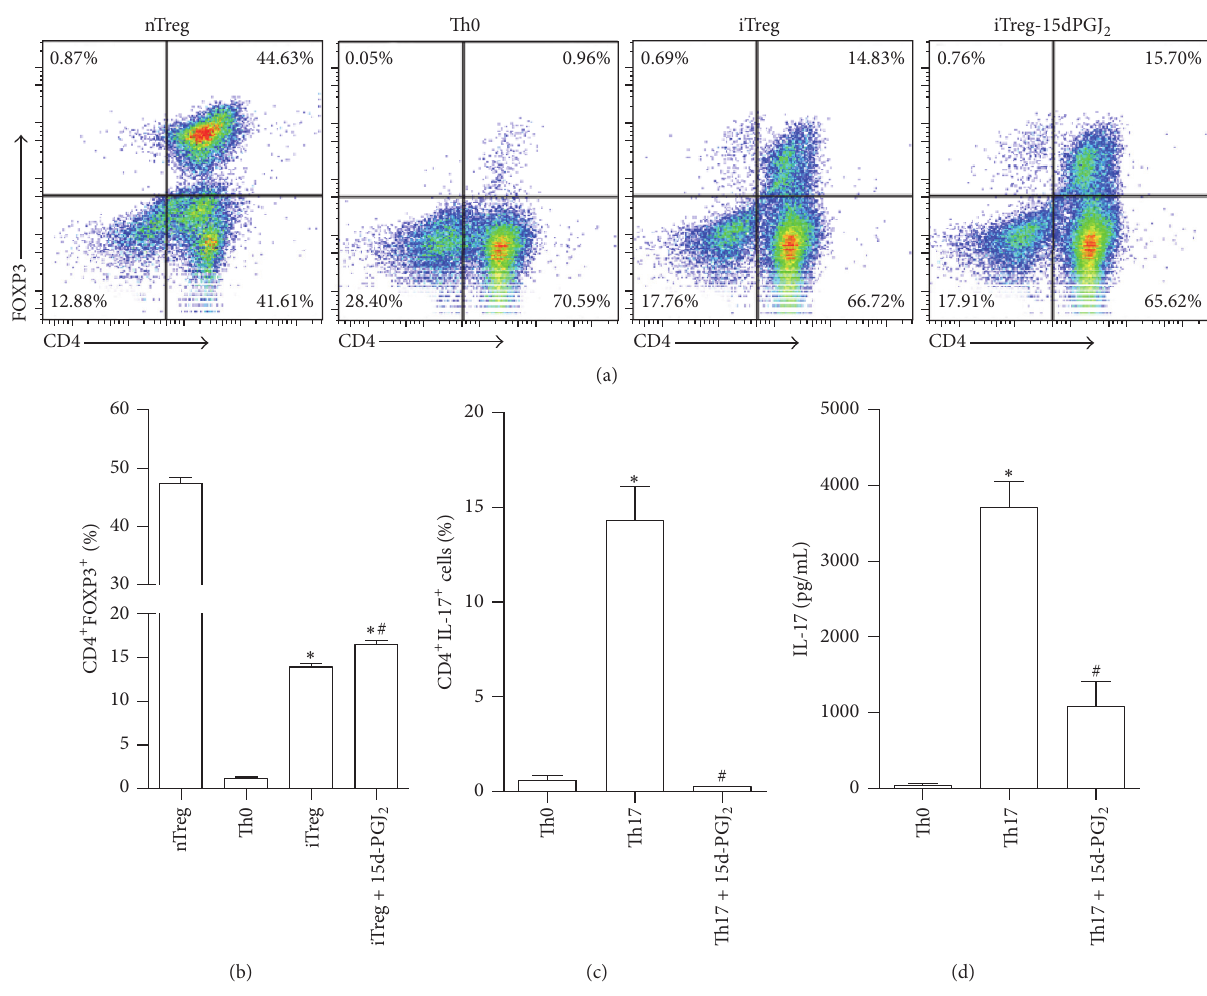
Figure 6: 15d-PGJ 2 altered the profile of CD4 + CD25 − cells under polarizing conditions. Isolated CD4 + CD25 − cells from na¨ıve mice were cultured under Treg ((a)/(b)) or Th17 ((c)/(d)) polarizing conditions with or without 15d-PGJ 2 (5 𝜇 M). Natural Treg (nTreg, CD4 + CD25 + ) or Th0 (CD4 + CD25 − ) cells were used as positive (for Treg) and negative differentiation controls. The bars represent the percentage of TCD4 + cells expressing FOXP3 or IL-17. In (d), IL-17 levels were measured into supernatant culture from Th17 polarizing condition by ELISA assay. The results are expressed as the mean ± SEM obtained from triplicate samples from one of three independent experiments ( N = 3 per group). ∗ 𝑃 < 0.05 relative to the vehicle group. ∗ 𝑃 < 0.05 compared with Th0; # 𝑃 < 0.05 compared with iTreg (b). ∗ 𝑃 < 0.05 compared with Th0; # 𝑃 < 0.05 compared with Th17